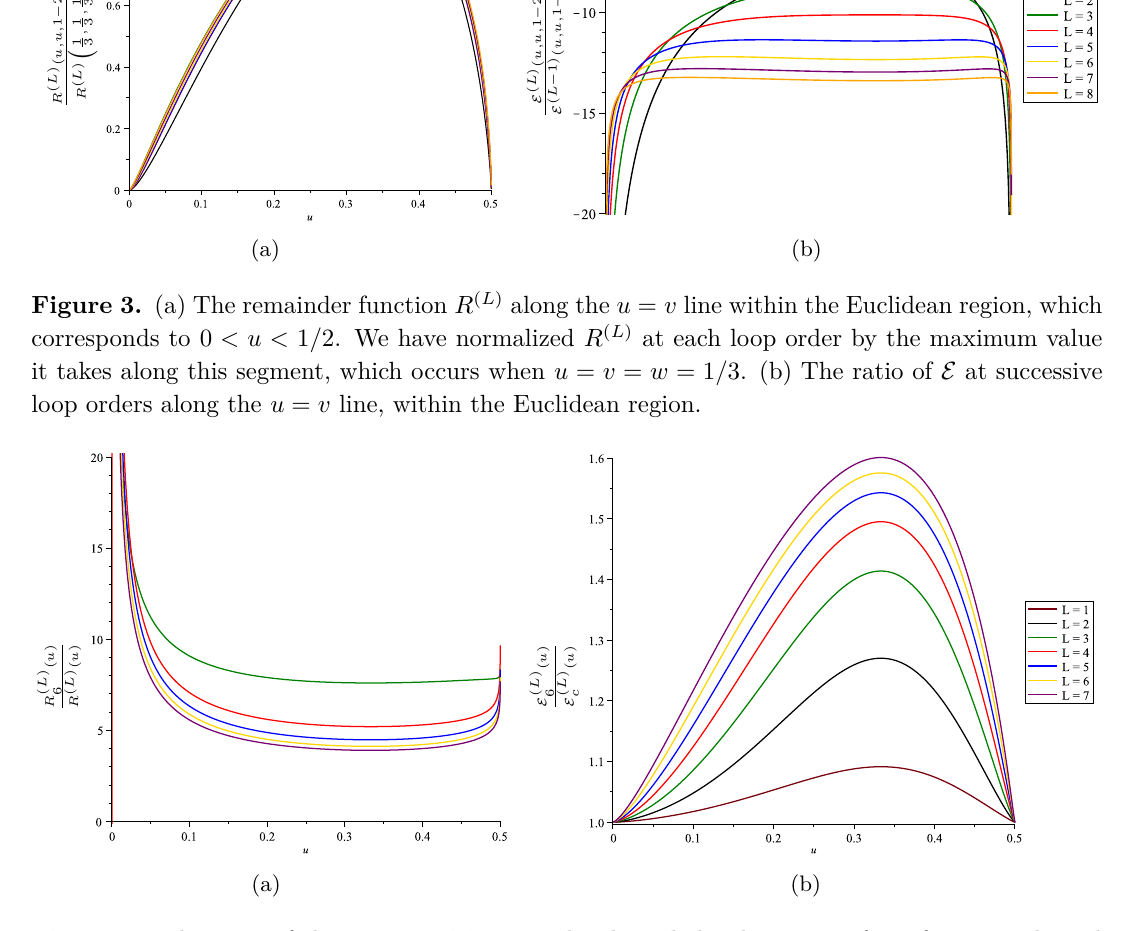
Figure 4. The ratio of the six-point MHV amplitude and the three-point form factor, evaluated on different sides of the antipodal duality on the line ( u, u, 1 − 2 u ) in the form factor variables. The six-point remainder function is denoted by R ( L ) ( u ) , while the cosmically and BDS-like normalized 6 amplitude is denoted by E ( L ) ( u ) 6